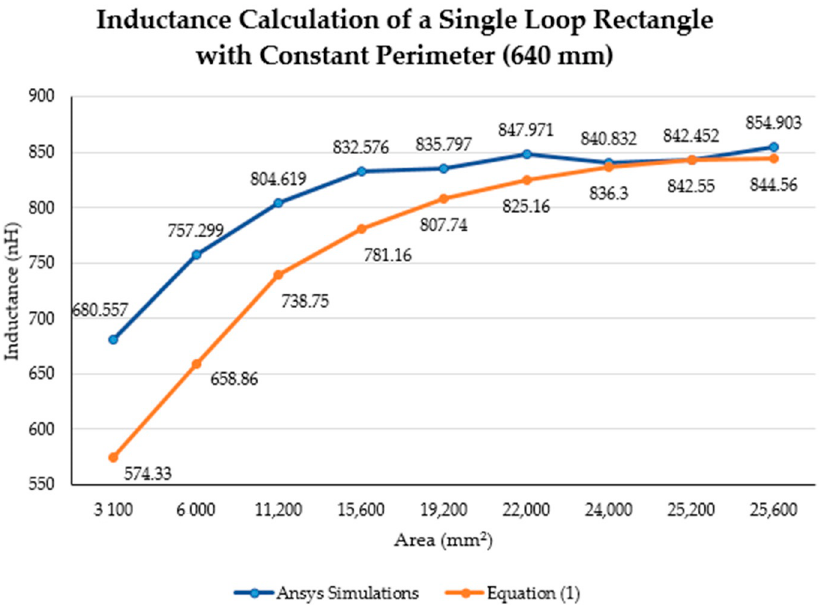
Figure 13. Theoretical and simulated inductance calculation (nH) with a constant perimeter (640 mm).